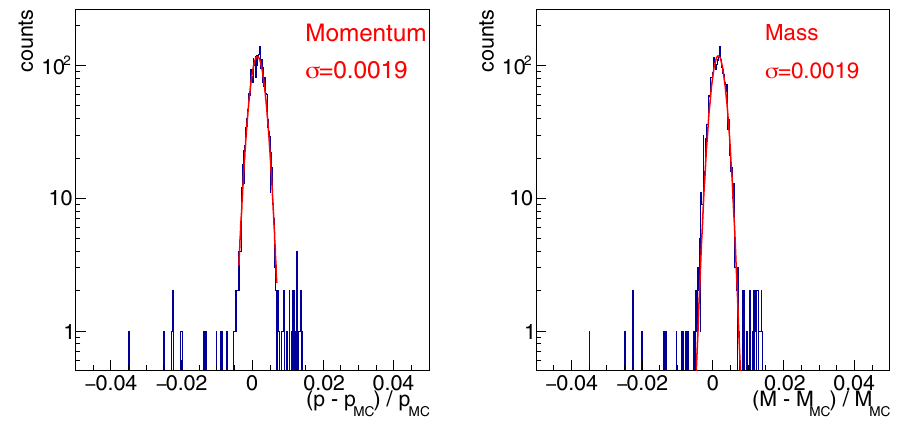
Figure 3. Relative momentum resolution - left picture. Relative mass resolution - right picture. Red line represents gaussian fit, sigma of which is shown with the